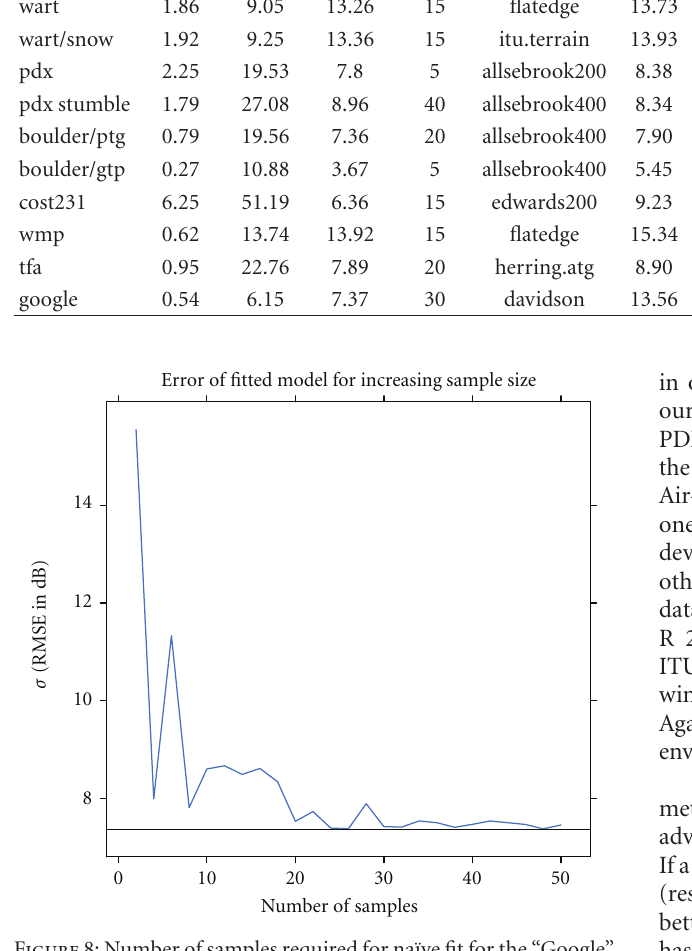
Figure 8: Number of samples required for na¨ıve fit for the “Google” data set. Plots show fit standard error for fits increasing random samples, and a horizontal line is given at the RMSE obtained for all